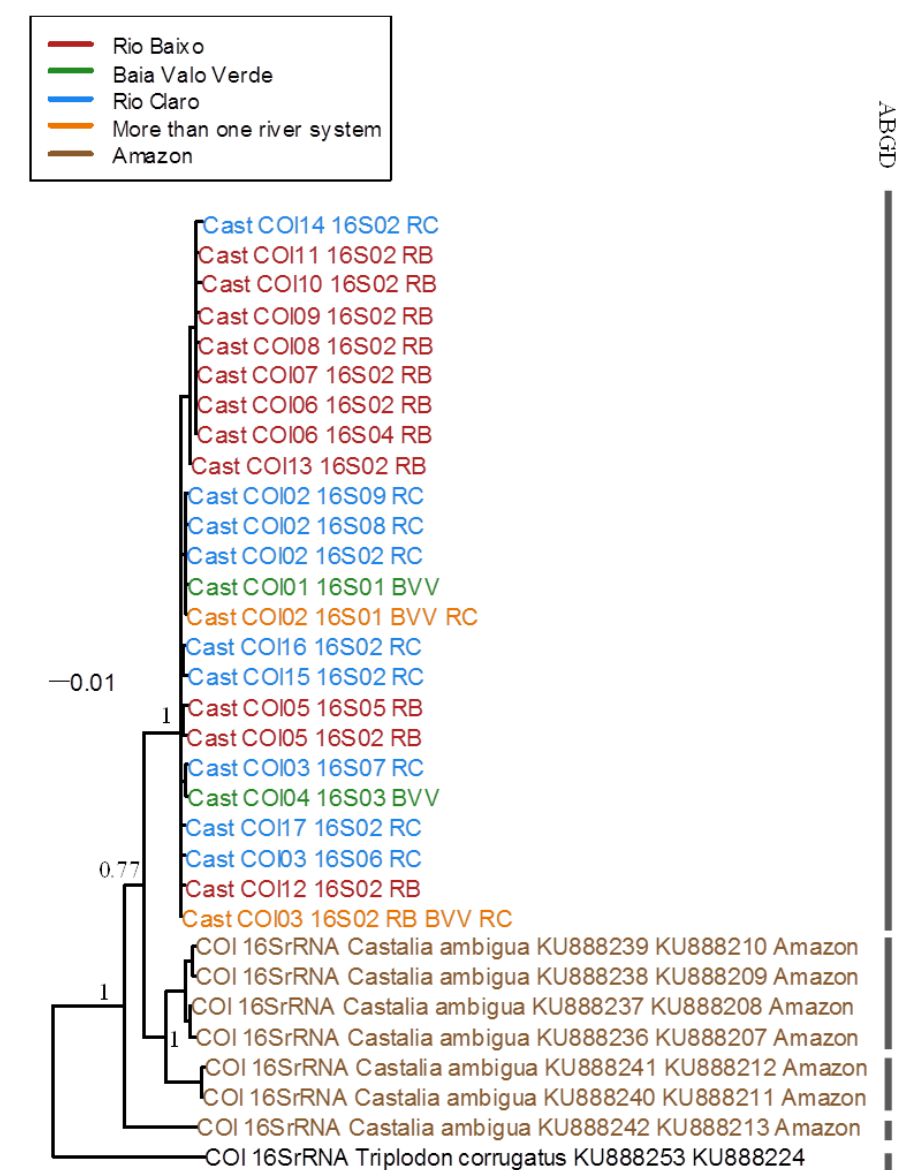
Figure 9. Bayesian phylogenetic analysis showing the relationships among individual mussels inferred from the combined mitochondrial COI and 16S rRNA DNA sequences (762 base-pairs) for C. ambigua , C. ambigua -like, C. inflata , and outgroup reference sequence for Triplodon corrugatus (KU888253). The analysis was run for 1.5 million generations to create a set of trees, of which 22,502 were sampled. The Bayesian phylogenetic consensus tree had a final average standard deviation of split frequencies of 0.002664 and with a − ln likelihood of − 2122.95. Branch lengths are proportional to inferred evolutionary distances. Numerals to the left of nodes indicate posterior probability support for the respective nodes. Designators for each DNA sequence include the location (RC—Claro Stream, BVV—Vale Verde Lake, RB—Baixo Stream). The distance bar is shown in units of substitutions per nucleotide site. ABGD on the right margin refers to species delimitations suggested by Automatic Barcode Gap Discovery [57].